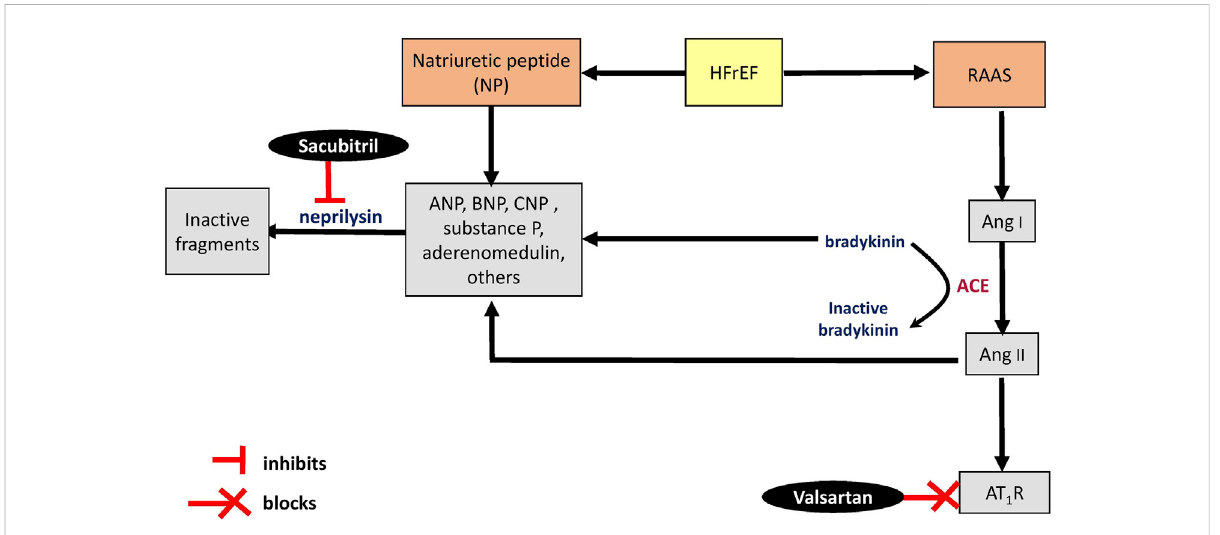
FIGURE 2 Schematicrepresentationofmechanismsofsacubitril/valsartanonrenin-angiotensin-aldosteronesystemandnatriureticpeptidesystem.ACE, angiotensin converting enzyme; Ang, angiotensin; ANP, atrial natriuretic peptide; ARB, angiotensin receptor blocker; ARNI, angiotensin receptor- neprilysin inhibitor; AT 1 R, angiotensin type 1 receptor; BNP, B-type natriuretic peptide; CNP, C-type natriuretic peptide; HFrEF, heart failure with reduced ejection fraction; NP natriuretic peptide; RAAS, renin-angiotensin-aldosterone system; ↑ ,